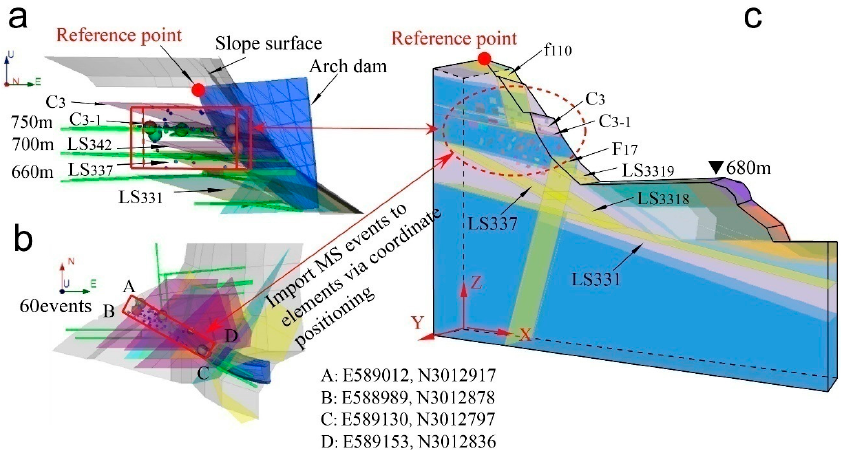
Figure 9. Import of microseismic (MS) data to the numerical model during the selected period between 1 December 2014 and 31 January 2015. ( a ) Front view, ( b ) top view, and ( c ) numerical model considering the MS e ff